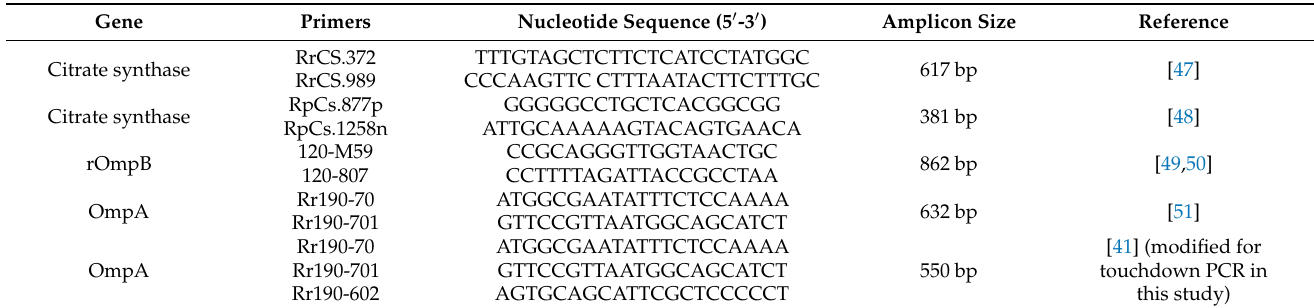
Table 1. Primers used to test for rickettsiae in this study.